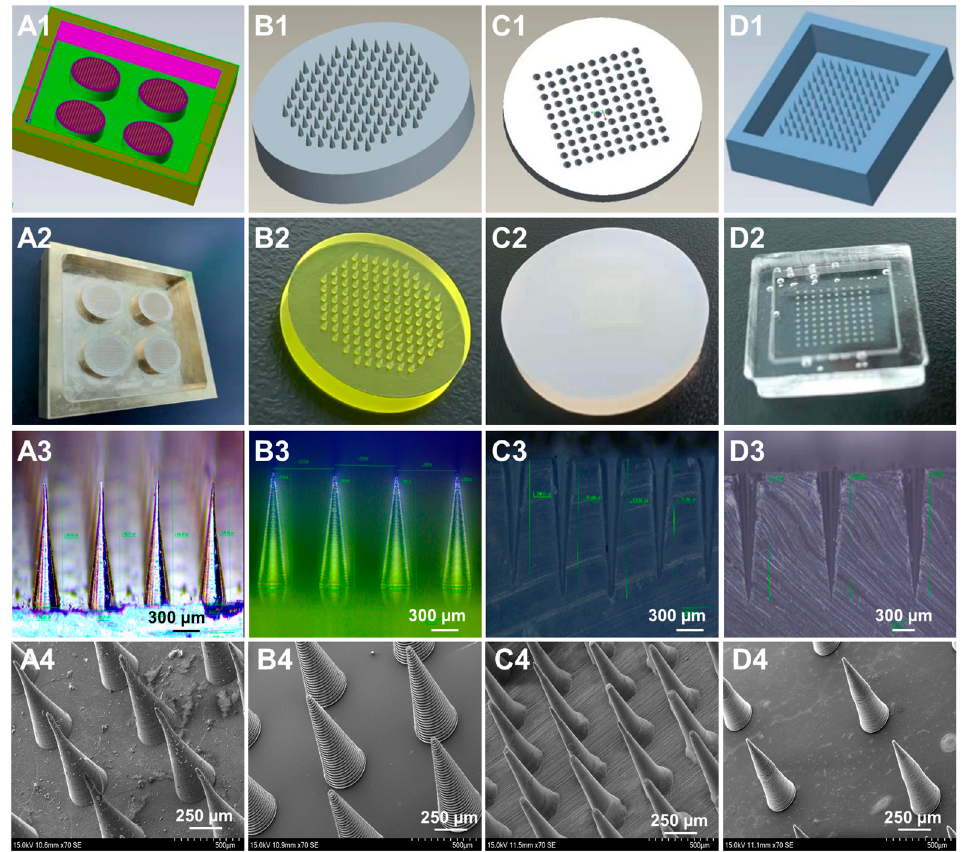
Figure 2. The 3D design drawings ( A1 , B1 , C1 , D1 ), physical pictures ( A2 , B2 , C2 , D2 ), and longitudinal sections ( A3 , B3 , C3 , D3 ) of male mold prepared by different processing technologies; the SEM images of MNs prepared by different mold processing technologies ( A4 , B4 , C4 , D4 ): ( A ) MEMS-CNC, ( B ) 3D-PuSL, ( C ) UV laser drilling, and ( D ) etching. Table 5. Geometric parameters of male mold prepared by di ff erent methods ( n = 6).